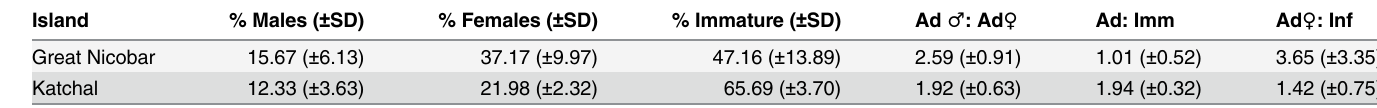
Table 4. Group structure and age-sex ratio of M . f . umbrosus in Nicobar Island Island % Males ( ± SD)